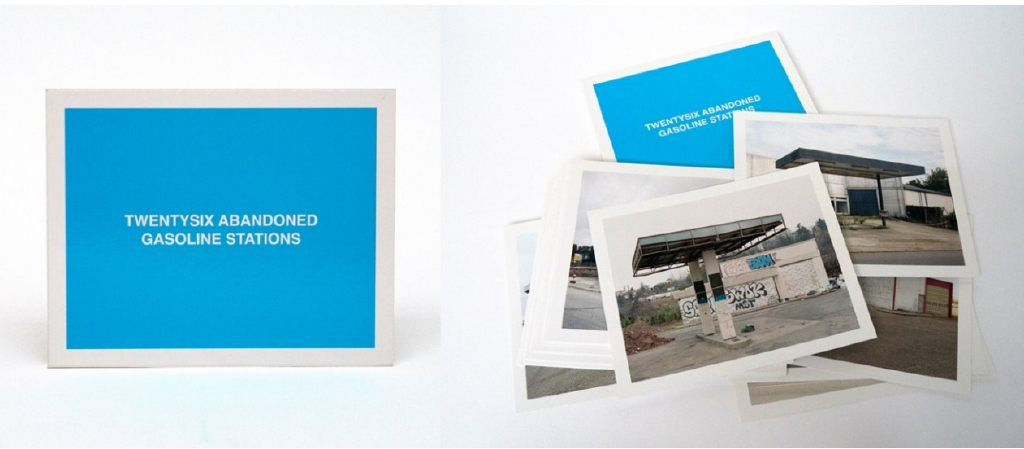
Figure 15. Eric Tabuchi, Twentysix Abandoned Gasoline Stations , 2009.